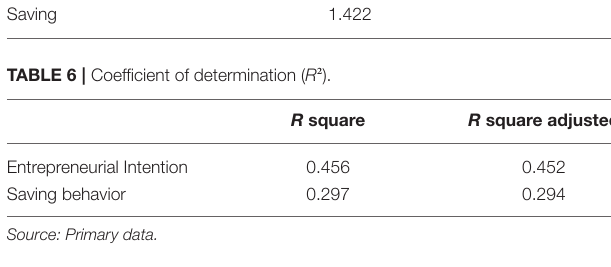
TABLE 7 | Construct cross-validated